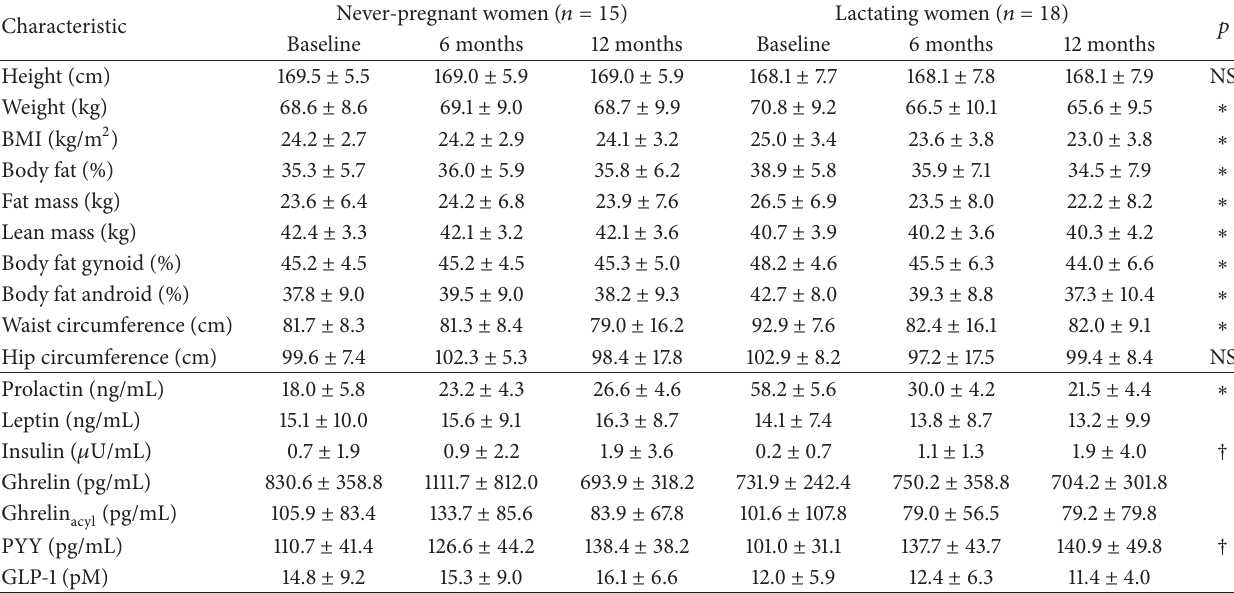
Table 4: Anthropometric characteristics and fasting hormone concentrations of postpartum lactating and never-pregnant control women completing the longitudinal study.